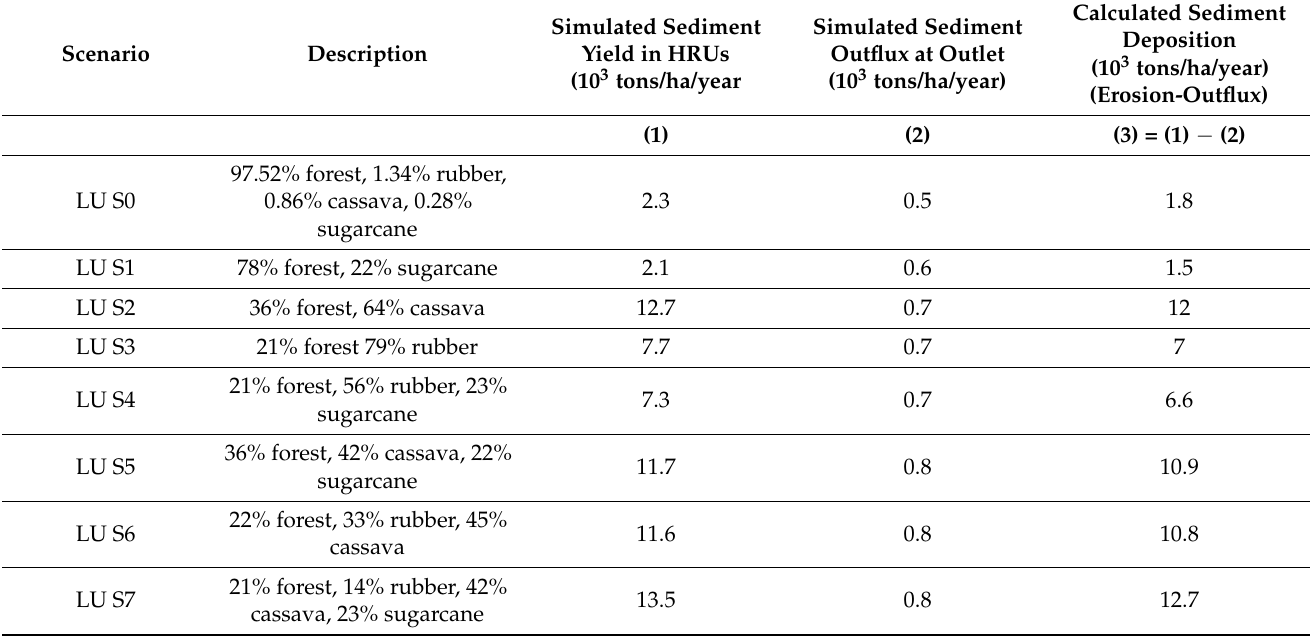
Table 7. Simulated sediment yield in HRUs, sediment outflux at the outlet, and calculated sediment deposition under different land-use change